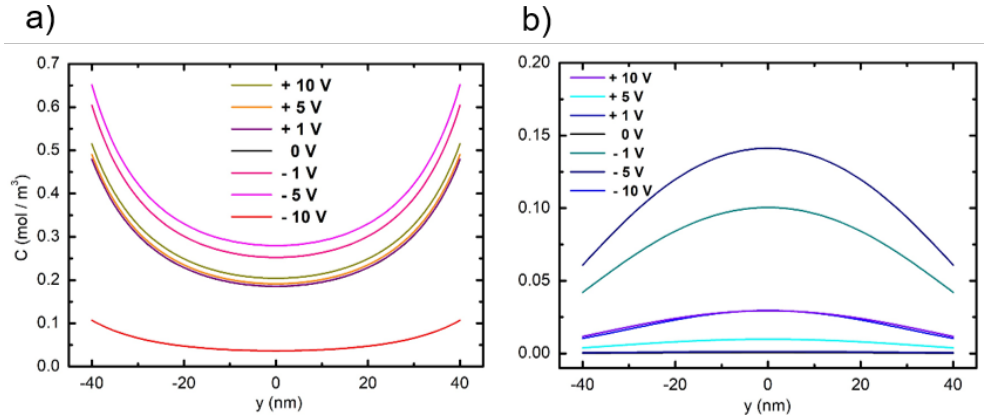
Figure 8. K + ( a )andCl − ( b )ionconcentrationalongthetransversalsectionatthemiddleofthenanochannel Figure 8. K + ( a ) and Cl − ( b ) ion concentration along the transversal section at the middle of the as a function of the applied voltage between the reservoirs (C Bulk = 10 − 5 M = 10 − 2 mol / m 3 ). Appl. Sci. 2020 , 10 , x FOR PEER REVIEW nanochannel as a function of the applied voltage between the reservoirs (C Bulk = 10 −5 M = 10 −2 mol/m 3 ).